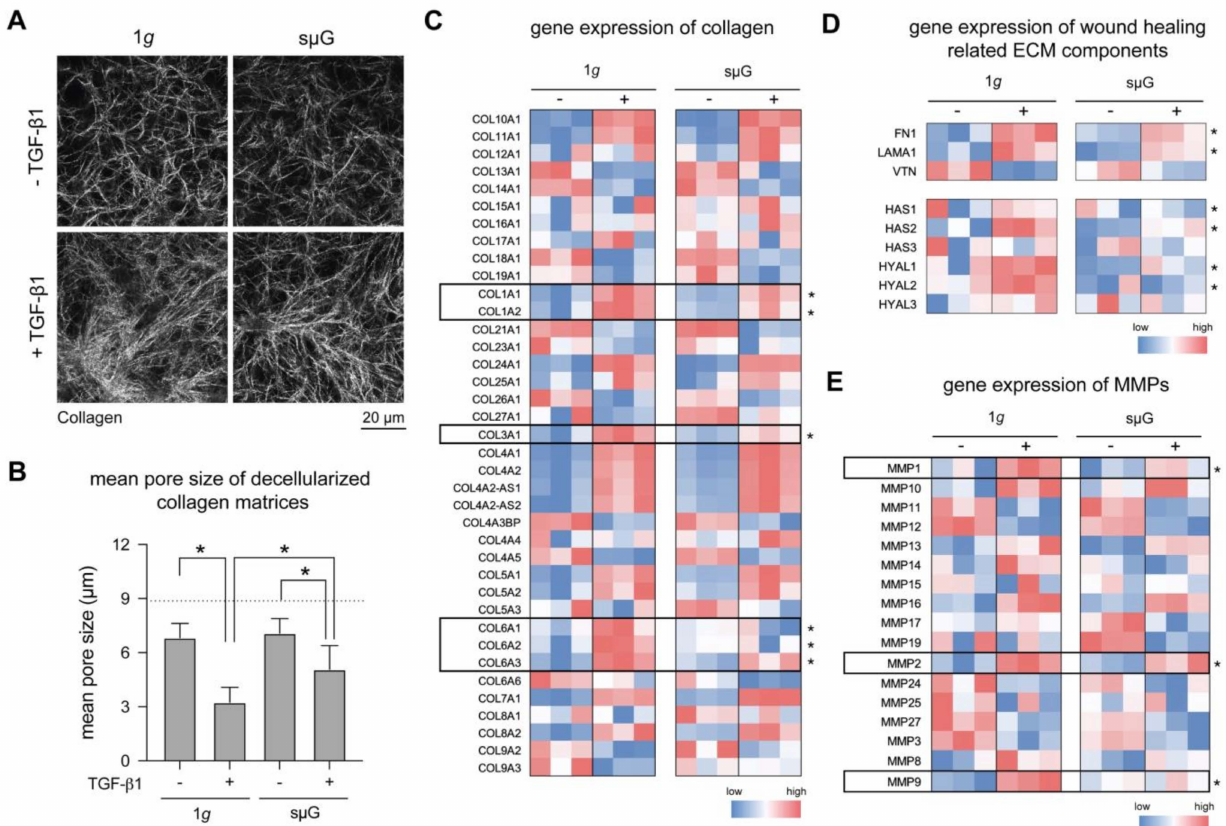
Figure 4. Matrix remodeling and ECM gene expression under 1 g and s µ G conditions. ( A ) Representative images of decellularized collagen matrices. Matrices were analyzed regarding ( B ) pore size. The image analysis was performed at least in triplicate with four positions per sample. Data are shown as mean +/ − SD. * indicates significant p ≤ 0.05. Gene expression using RNA-Seq data of ( C ) collagens, ( D ) wound healing related ECM factors, and (E) matrix metalloproteinases (MMPs) in both 1 g and s µ G conditions. Data are shown as a heatmap using colors on a scale from red (high expression) to blue (low expression). Statistical significance test was performed for TGF- β 1-treated samples between 1 g and s µ G conditions for Figure 4C–E, which is indicated by * for p -value ≤ 0.05. The experiment was performed in three